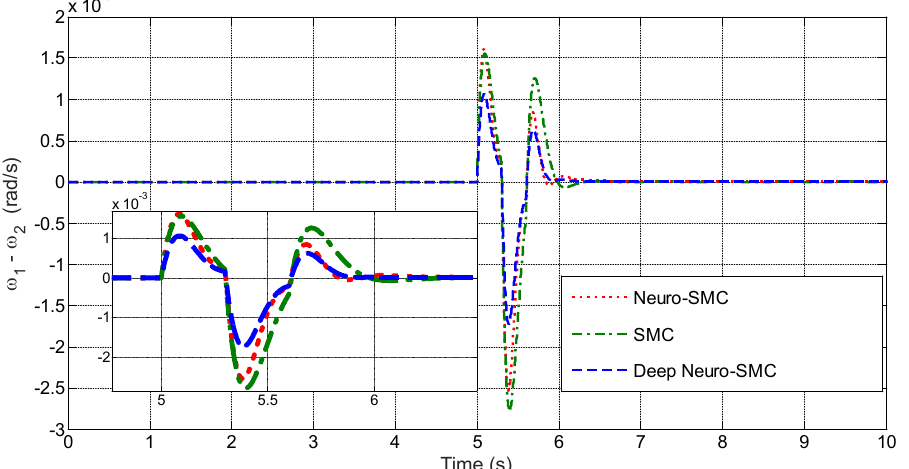
Figure 6. Comparison of generator speed changes (first case).